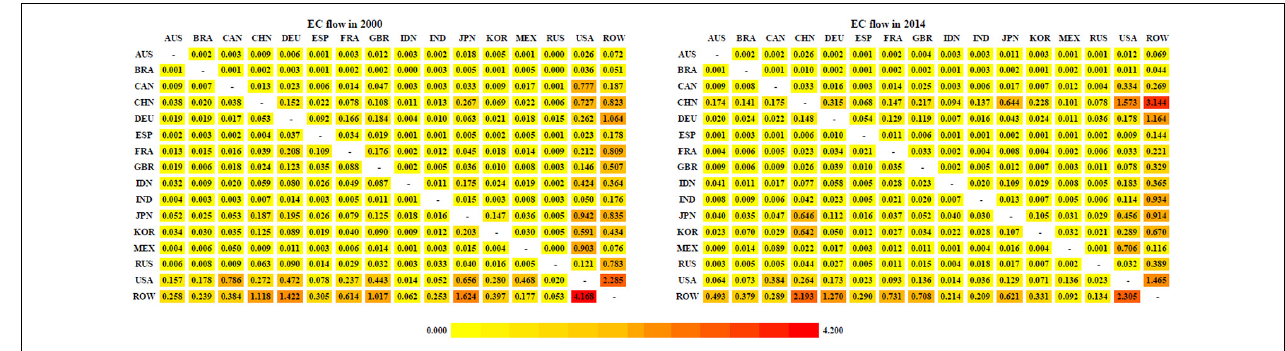
FIGURE 2 | Information and communication technologies embodied carbon emissions flow among major countries in 2000 and 2014. Note: EC represents the embodied carbon emissions, ECI represents the embodied carbon emission